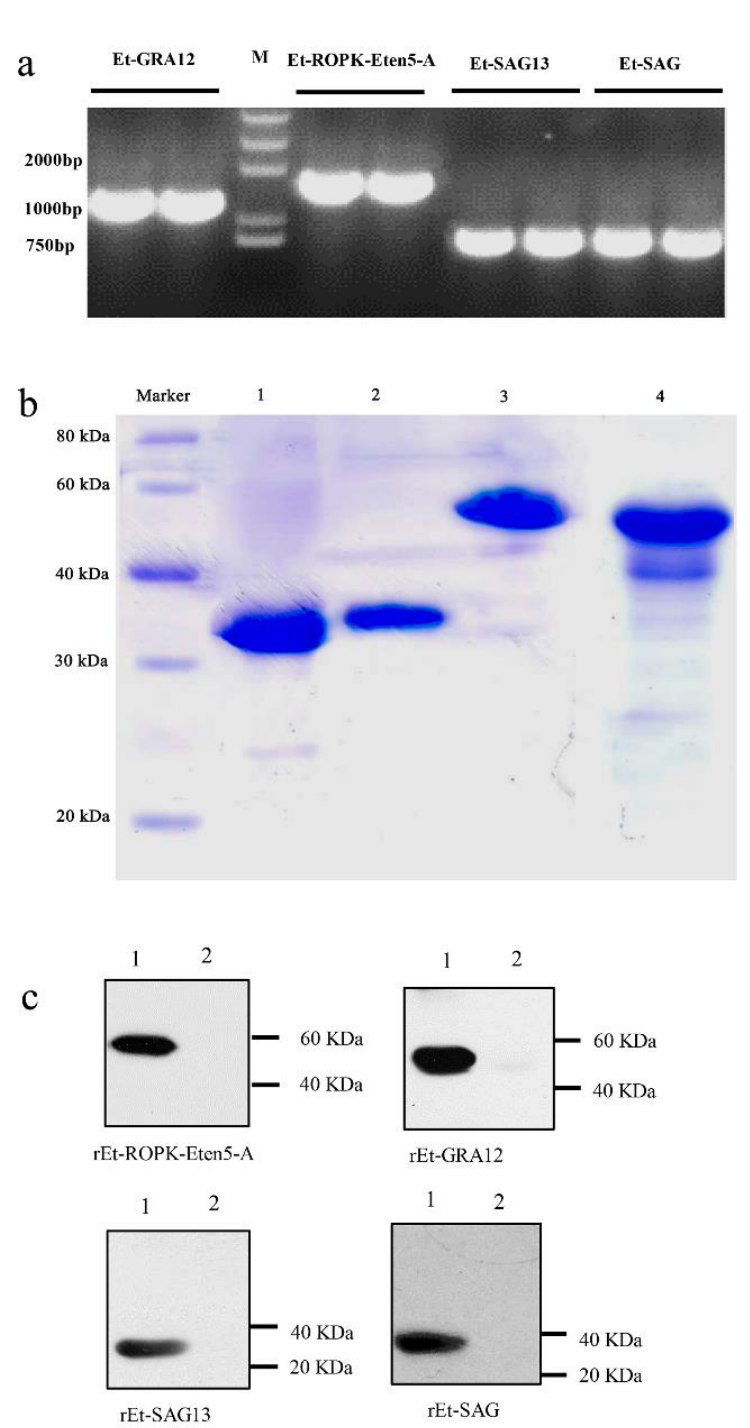
Figure 5. Cloning, expression and immunogenicity identification of four sporozoite recombinant proteins. ( a ) The full coding sequences of Et-ROPK-Eten5-A, Et-GRA12, Et-SAG and Et-SAG13 without the signal peptide sequences were amplified from cDNA. ( b ) Purification of recombinant proteins. Lane 1, purified rEt-SAG13 protein; Lane 2, purified rEt-SAG protein; Lane 3, purified rEt-ROPK-Eten5-A protein; Lane 4, purified rEt-GRA12 protein. ( c ) Western blotting analysis of recombinant proteins. Lane 1, E. tenella positive serum; Lane 2, negative serum.